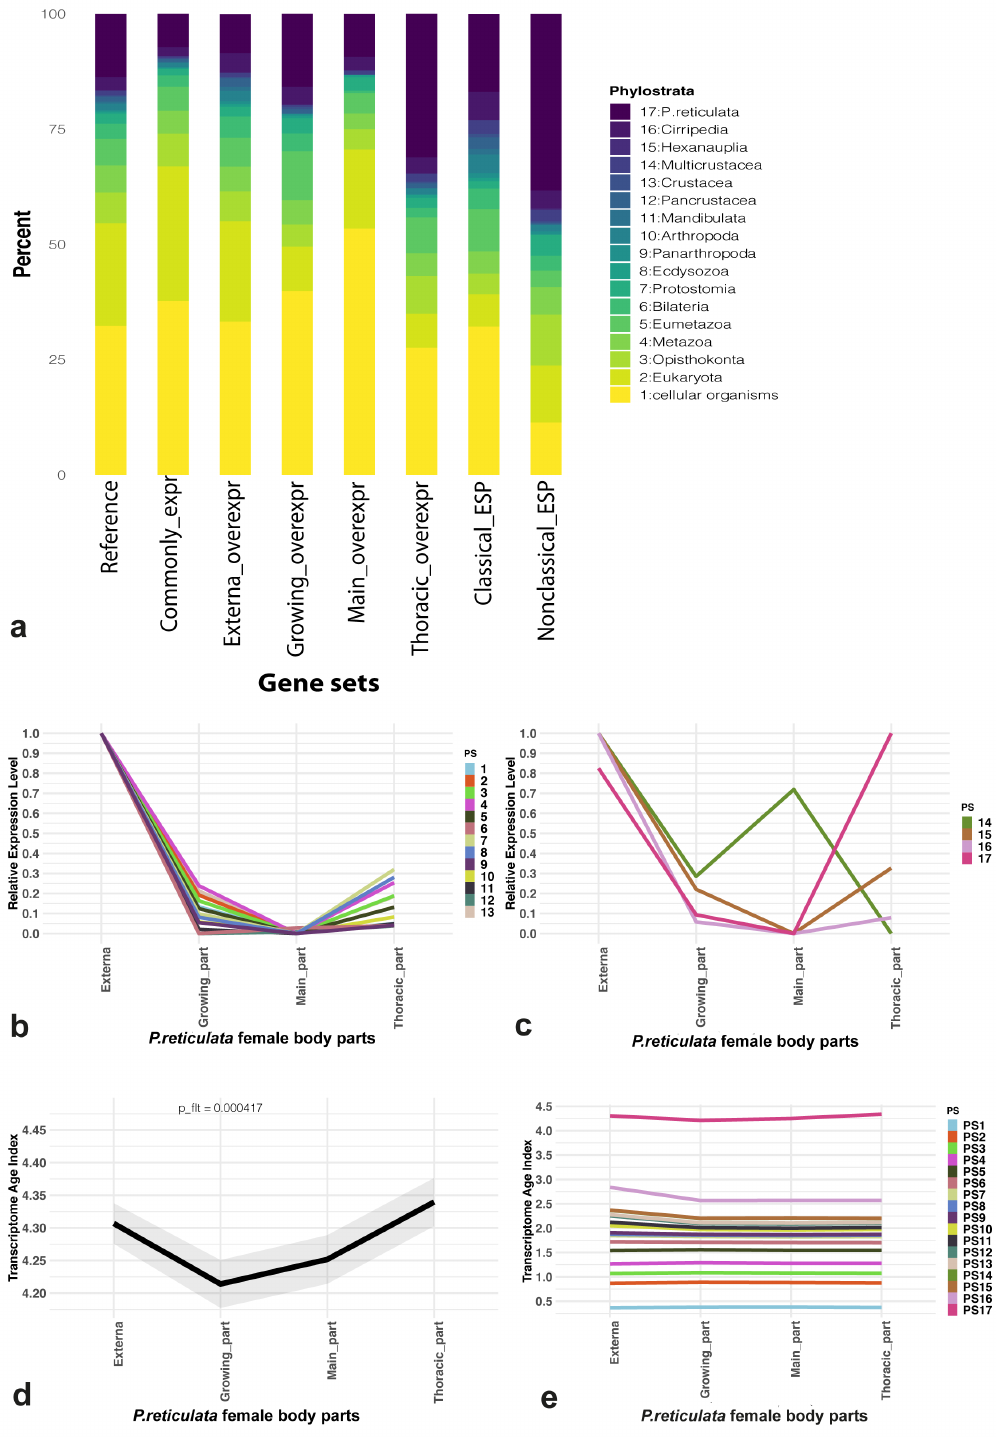
Figure 4. Phylostratigraphy and evolutionary transcriptomics results. ( a ) Phylostratigraphic composition analysis results for P. reticulata reference gene set (“reference”), set of genes with noticeable ( ≥ 2 transcripts-per-million) expression in all female body parts considered (“common expr”), sets of genes over-expressed (externa/growing/main trunk/thoracic_overexpr) and sets of genes encoding potential “classical” (“classical_ESP”) and “non-classical” (“nonclassical_ESP”) excretory/secretory proteins (ESP). ( b , c ) Relative mean expression levels of phylostrata which occurred “before” ( b ) or “after” ( c ) division of Crustacea. ( d ) Transcriptome Age Indices (TAI) variation for female body parts considered. A lower TAI value describes an “older” transcriptome, whereas a higher TAI denotes a “younger” one. ( e ) The cumulative phylostrata contribution to the final (global) TAI